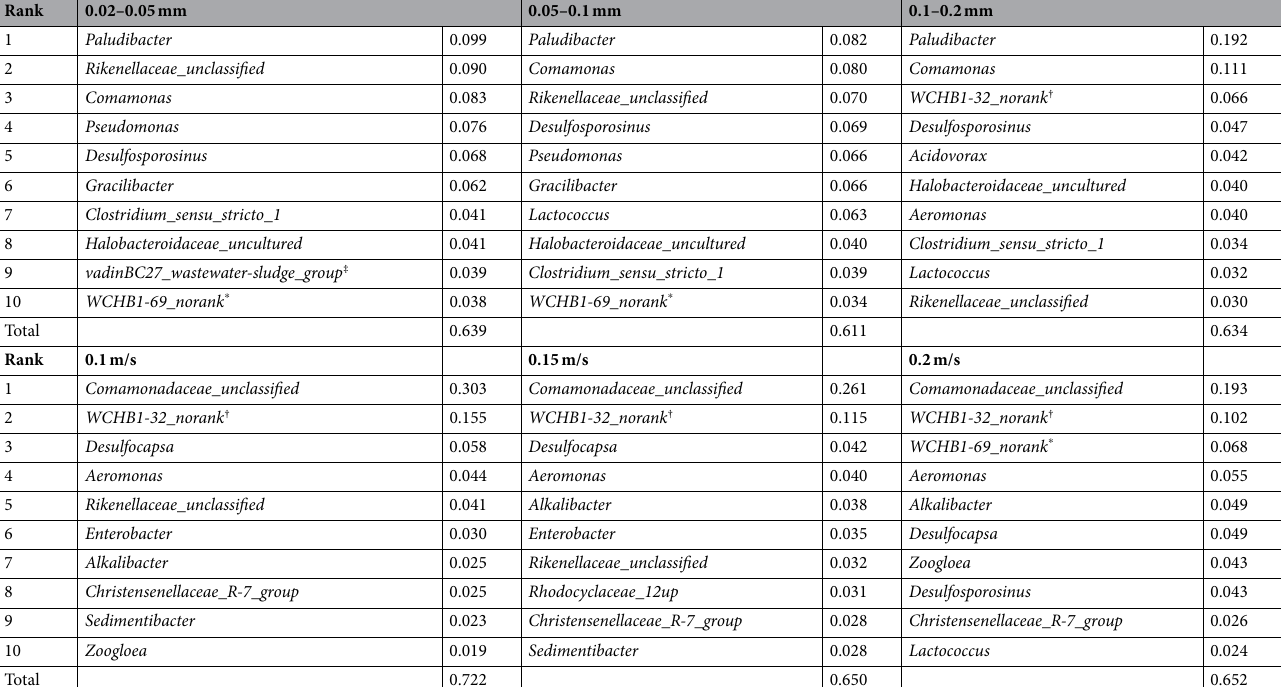
Table 3. The 10 most abundant genera under different experimental conditions. ‡ p_ Bacteroidetes ;